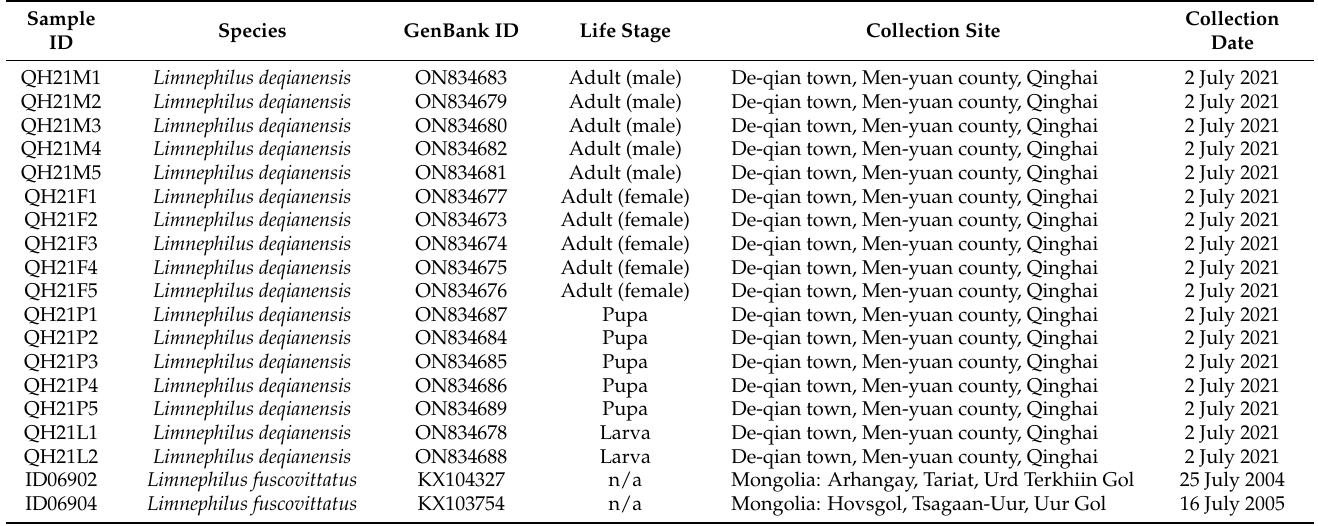
Table 3. Specimens used in larva-male-female-pupa associations of Limnephilus deqianensis n. sp. Sample